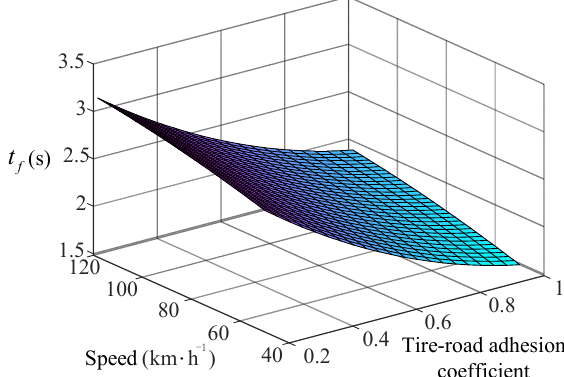
Figure 4. Three-dimensional plot of lane change time versus vehicle speed and coefficient of adhe- sion.